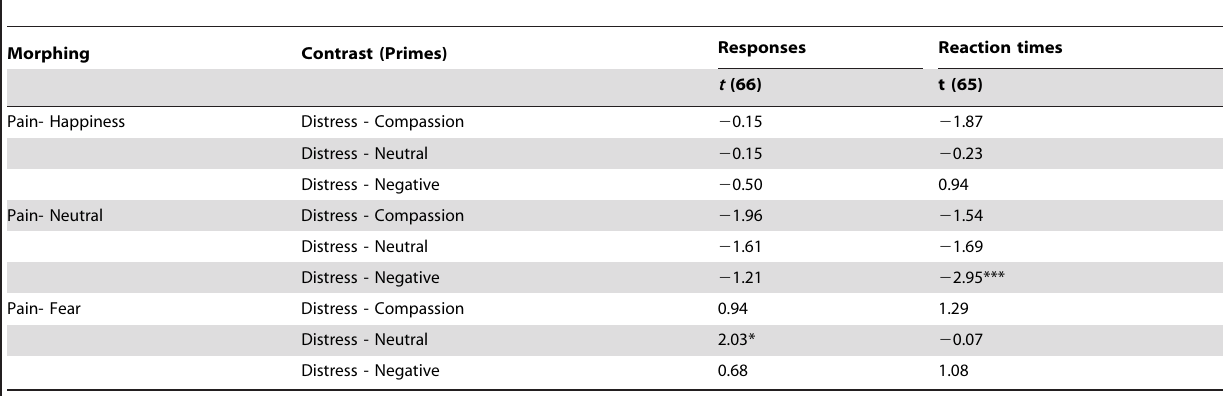
Table 2. One-sample t tests for each type of ambiguous expression of pain (i.e., morphed with happiness, neutral, and fearful expressions) and for each